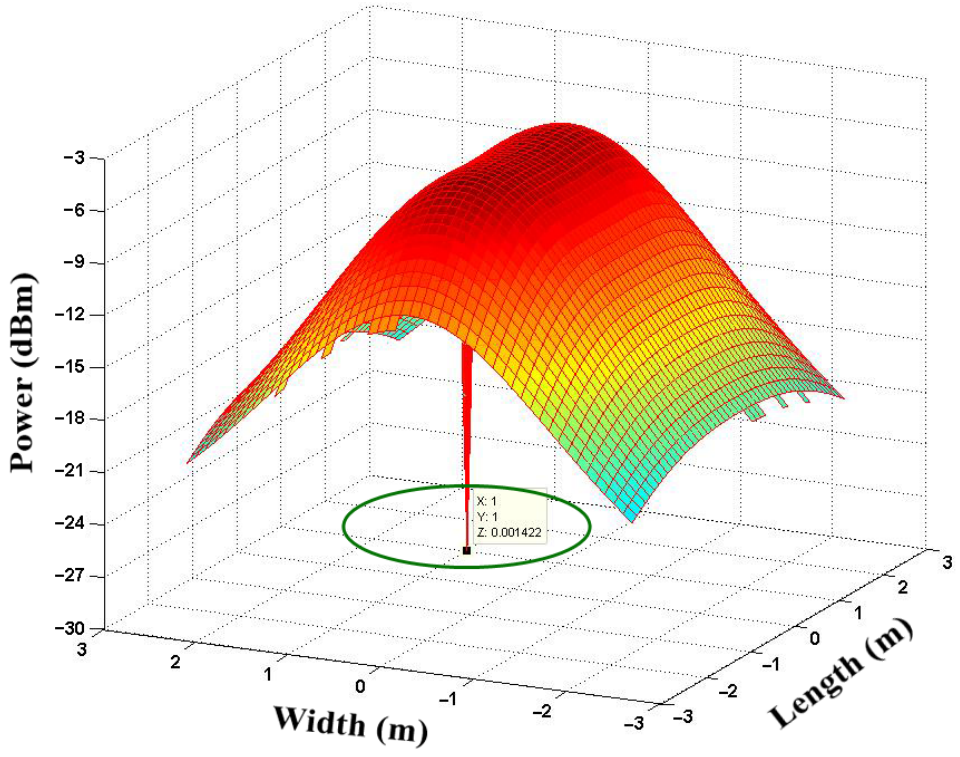
Figure 11. Allocation of the signal power received at RX Location 1